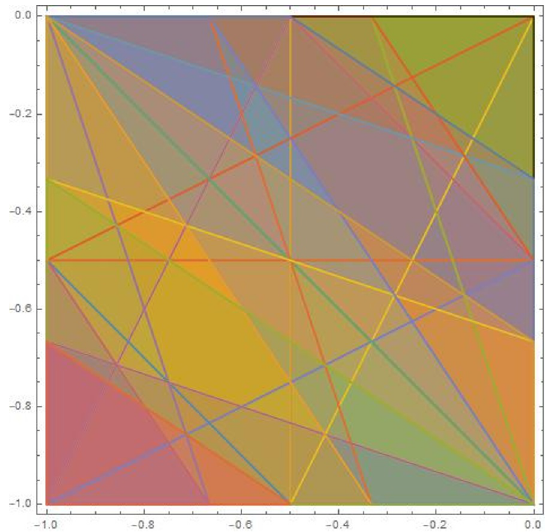
Figure 3 . The various domains in [ˆ φ ± ] space for which the added constants to the brackets 1 , 2 in (3.35) take specific values. For example, all added integers vanish in the domain enclosed by the red and yellow line in the upper right corner. As one crosses domain borders, an integer in one of the ten brackets appearing in (3.35)